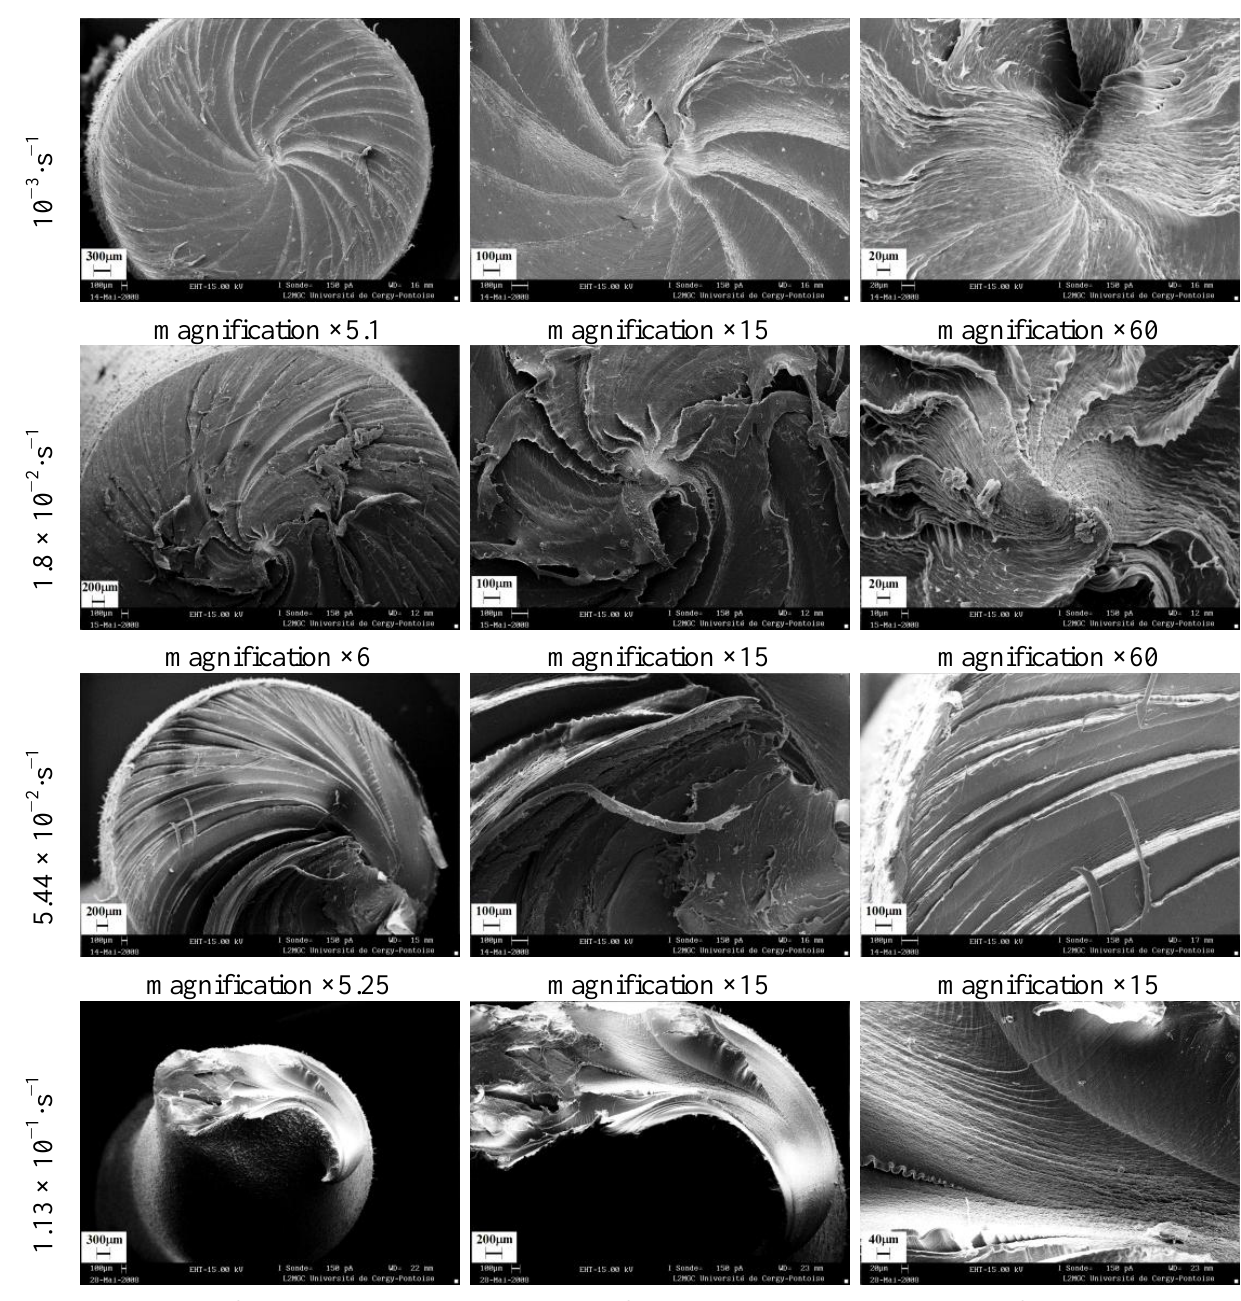
Figure 26. Fractography of PA66 torsion test for different equivalent strain